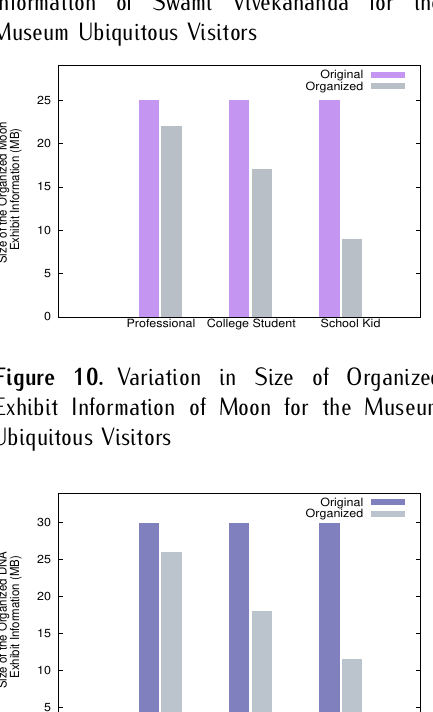
Figure 9. Variation in Size of Organized Exhibit